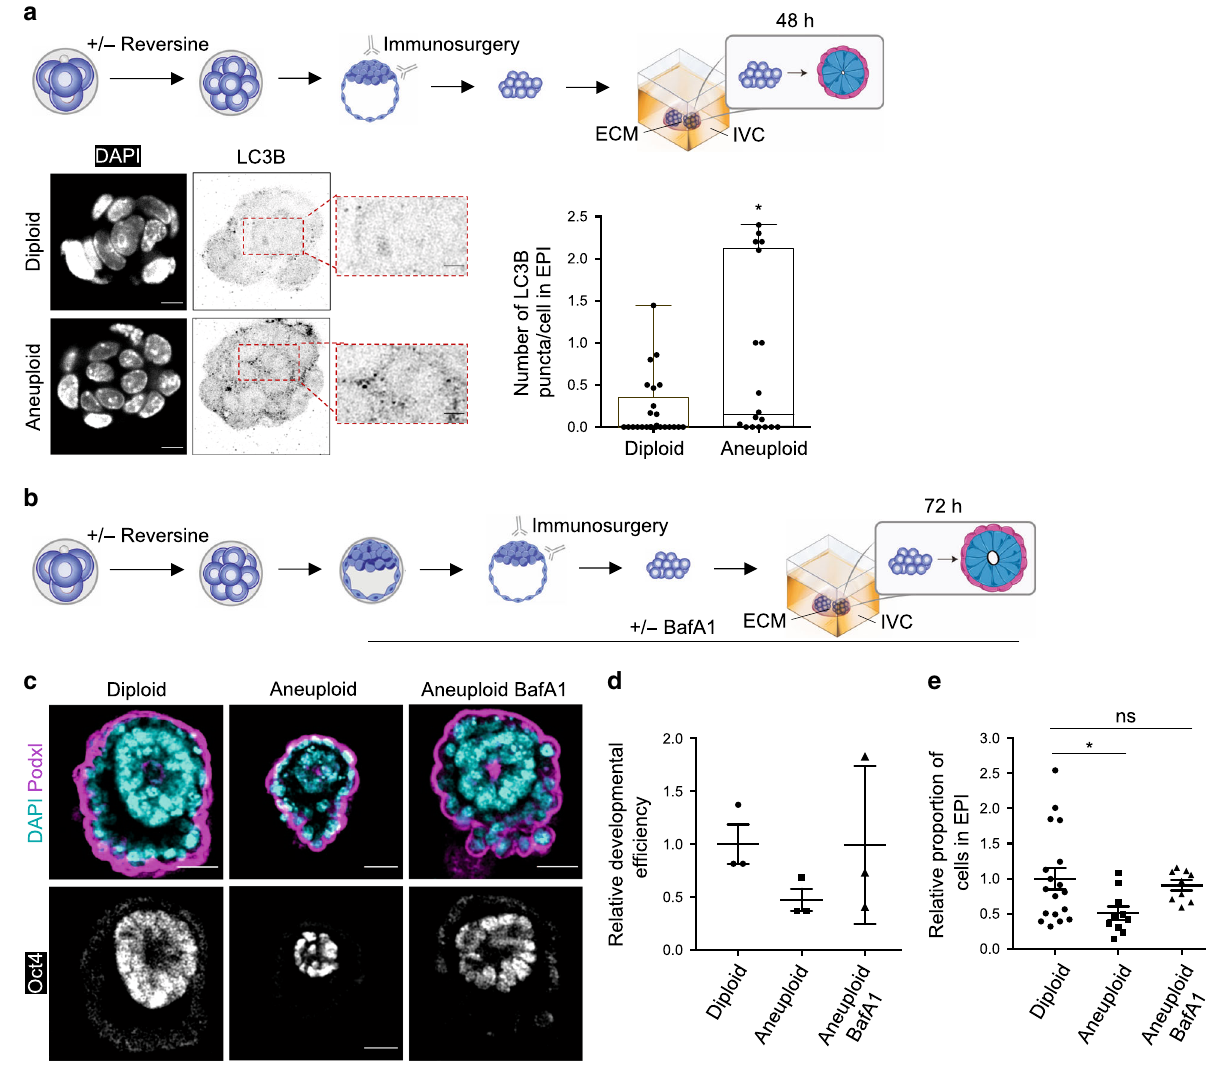
Fig. 6 Autophagy upregulation mediates cell death in the ICM of aneuploid peri-implantation embryos. a Embryos were treated at the four- to eight-cell stage with reversine or DMSO. Control (diploid) and reversine-treated (aneuploid). After immunosurgery at the late blastocyst stage, ICMs were embedded in Matrigel and cultured in IVC medium. LC3B immunostaining was analysed in diploid and aneuploid EPIs after 48 h IVC in vitro culture. Each dot represents the average number of LC3B puncta/cell in each EPI. Scale bars, 7 μ m. Squares indicate magni fi ed regions. Scale bars, 2 μ m. Mann – Whitney test, * p = 0.0409. Diploid n = 25 embryos and aneuploid n = 18 embryos. Data are shown as individual data points in a Box and Whiskers graph (bottom: 25%; top: 75%; line: median; whiskers: min to max). b Embryos were treated at the four- to eight-cell stage with reversine or DMSO. Diploid and aneuploid embryos were cultured in DMSO or BafA1 during blastocyst maturation. Immunosurgery was performed and ICMs were cultured as above for 72 h in DMSO or BafA1. c Diploid and aneuploid ICMs were cultured as shown in ( b ) for 72 h and analysed for the ef fi ciency of formation of an organised structure comprising an epithelised EPI surrounded by a PE layer with a central lumen. Scale bars, 30 µ m. d Relative (to diploids) ef fi ciency of ICMs in forming an organised structure, assessed according to ( c ), was evaluated. n = 3 independent experimental groups. Diploid n = 34 embryos, aneuploid n = 36 embryos and aneuploid BafA1 = 31 embryos. e Relative (to diploids) number of cells in the EPI was analysed for organised structures obtained in ( c ) for all three conditions. One-way ANOVA test, * p = 0.0450. For c and e , diploid n = 18 embryos; n = 1246 EPI cells, aneuploid n = 10 embryos; n = 352 EPI cells and Aneuploid BafA1 = 9 embryos; n = 563 EPI cells. For graphs d and e , all data are mean ± s.e.m. For all the graphs, ns not signi fi cantly different. Source data are provided as a Source Data fi